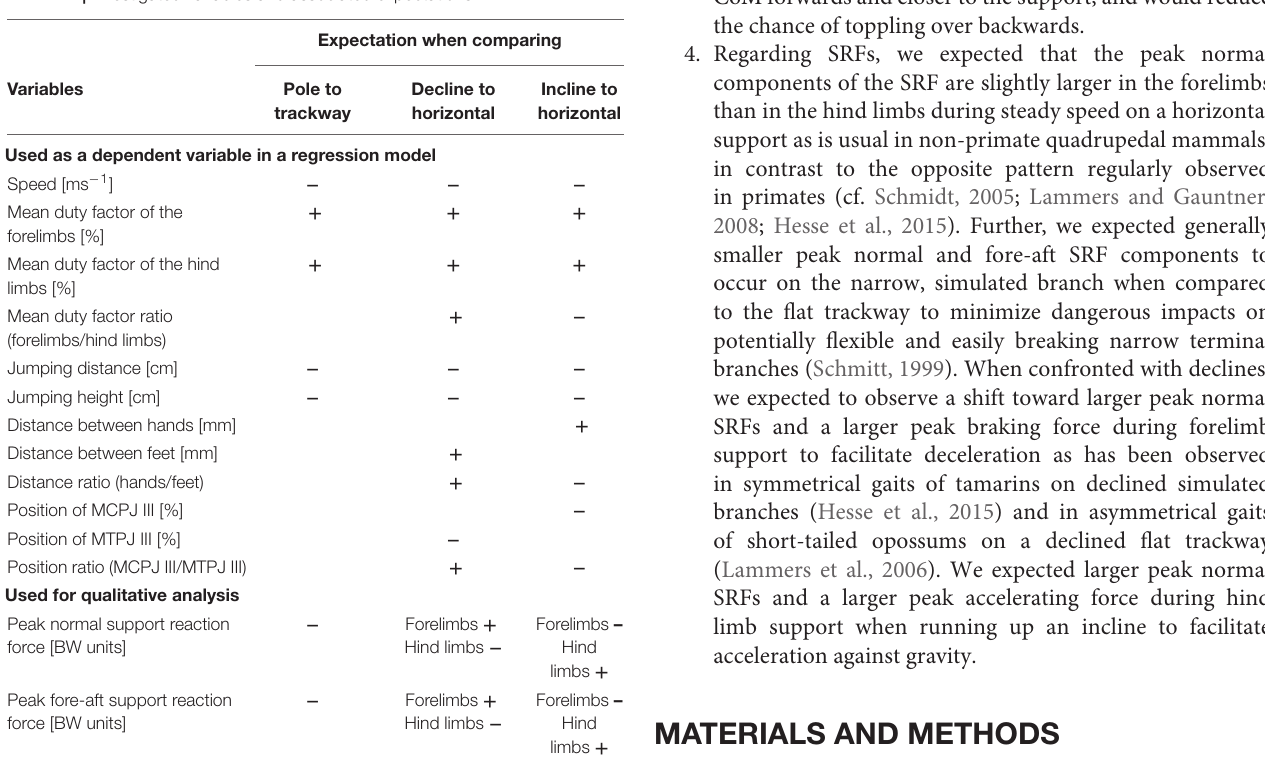
TABLE 1 | Investigated variables and associated